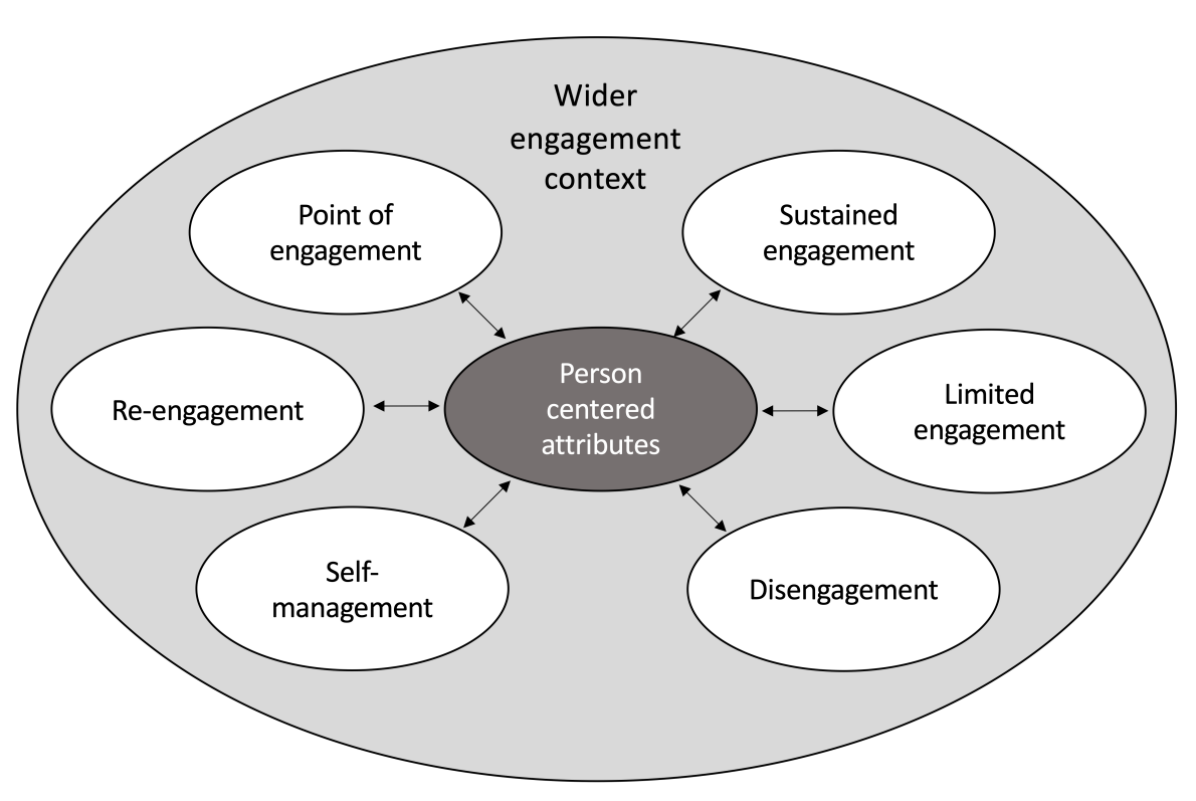
Figure 2. Mobile health engagement stages in this study (based on O’Brien & Toms